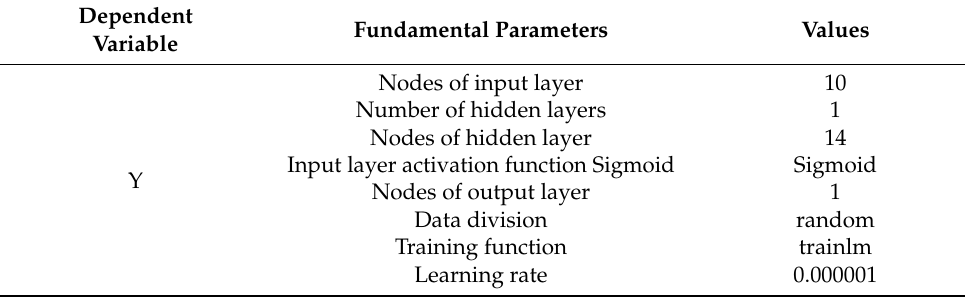
Table 7. Fundamental parameters of PCA-BP neural